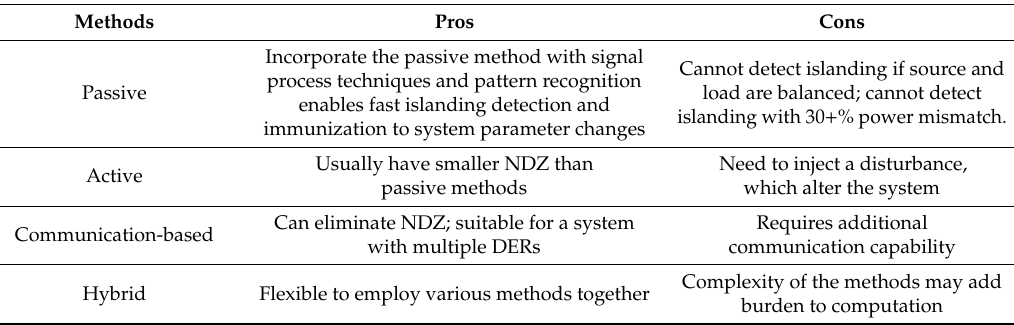
Table 1. A comparison between the islanding detection